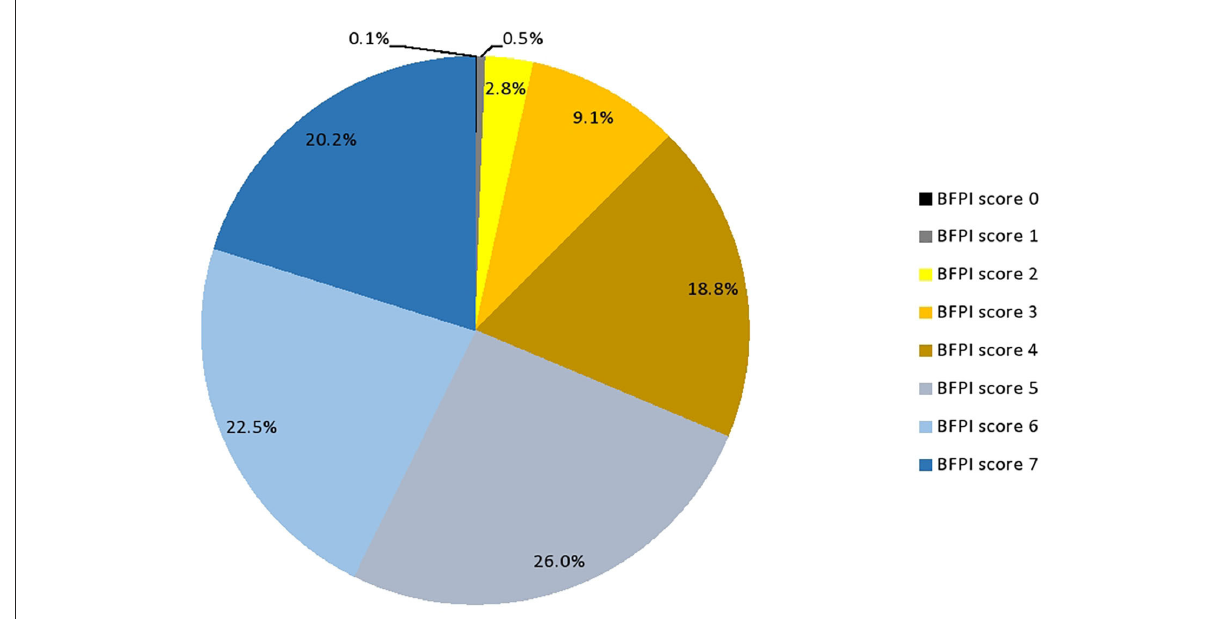
FIGURE1 Breastfeeding performance score of reproductive age mothers in